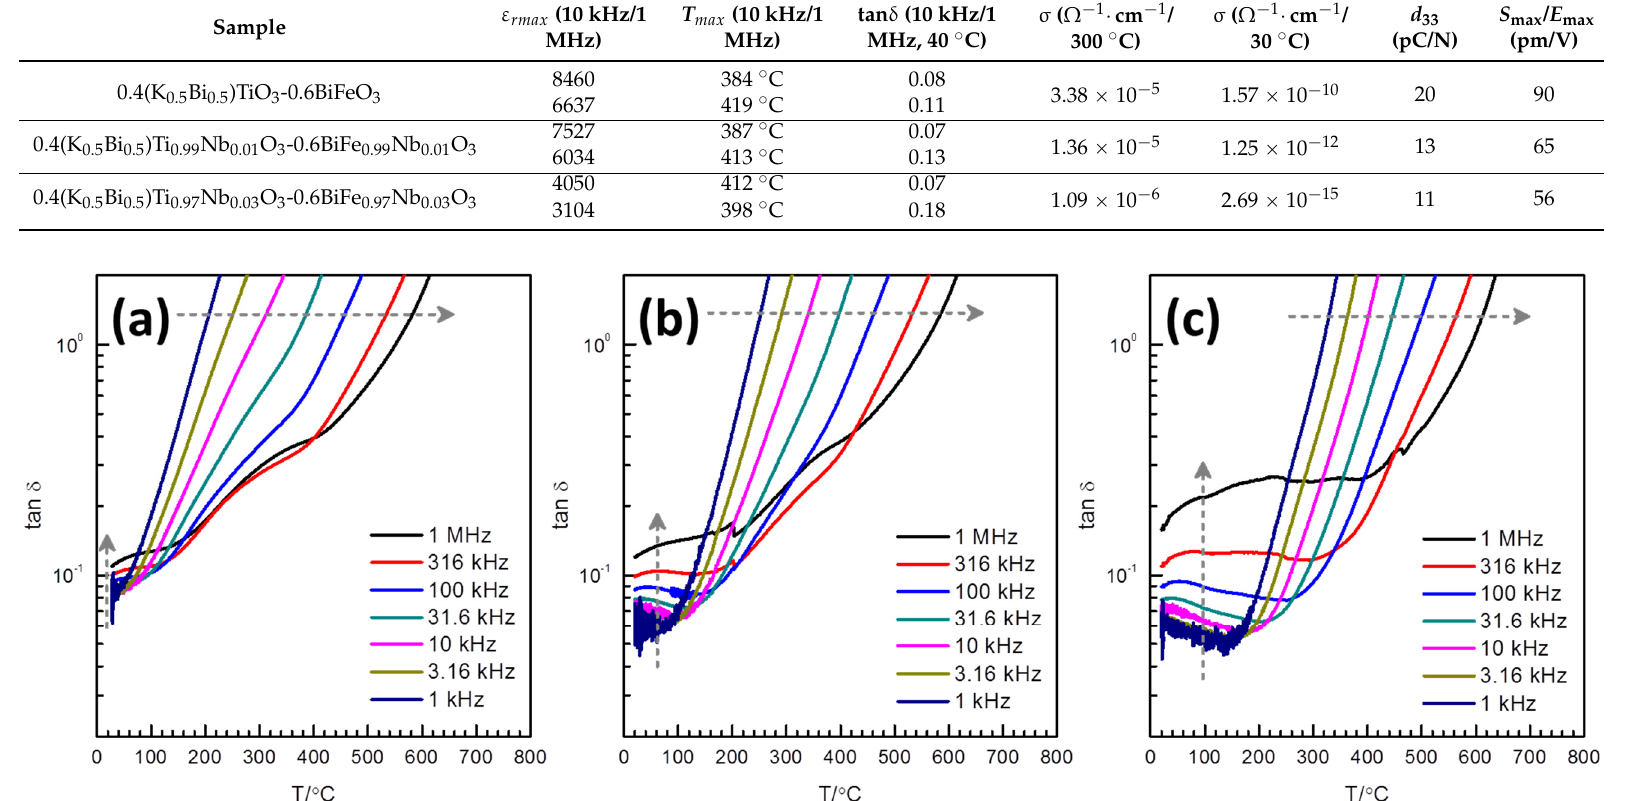
Figure 5. Loss tangent vs. temperature for 0.4(K 0.5 Bi 0.5 )Ti (1 − x ) Nb x O 3 ‐ 0.6BiFe (1 − x ) Nb x O 3 samples sintered at 1050 °C for 1 h: ( a ) x = 0.00; ( b ) x = 0.01; and ( c ) x = 0.03.